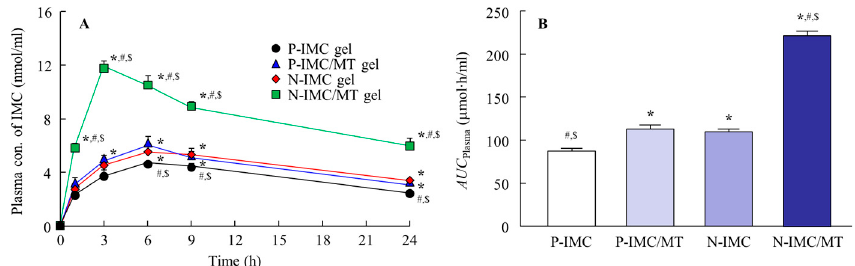
Figure 6. The percutaneous absorption of IMC transdermal formulations. ( A ) Transdermal penetration for the IMC transdermal formulations. ( B ) AUC Plasma values for the IMC transdermal formulations. n = 6–7. * p < 0.05 vs. P-IMC gel for each category. # p < 0.05 vs. P-IMC/MT gel for each category. $ p < 0.05 vs. N-IMC gel for each category. The difference between the N-IMC and N-IMC/MT gels was significantly higher than that of the corresponding microparticles-based transdermal formulations, and the AUC Plasma for the N-IMC/MT gel was 2-fold higher than for the N-IMC gel. Table 2. Pharmacokinetic analysis of percutaneous absorption of the IMC transdermal formulations. Parameter